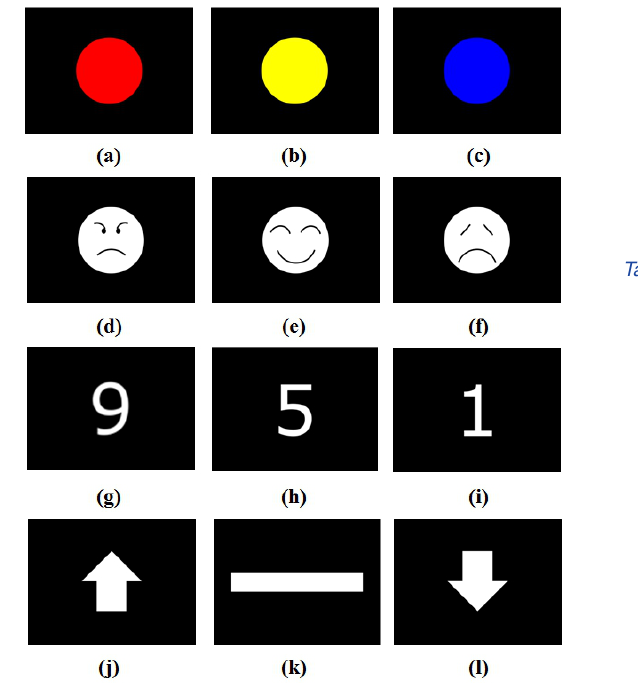
Figure 5. The visual stimuli projected on the Touch Ball: (a), (b) and (c) as Colour; (d),(e)and(f)asFacialexpression; (g),(h)and(i)asNumbers; (j), (k) and (l) as Arrows.